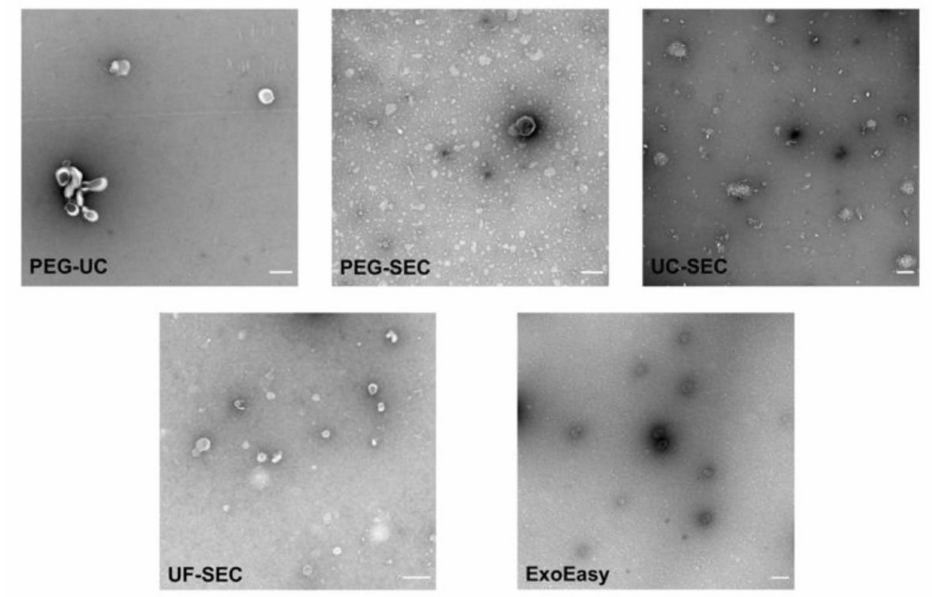
Figure 7. UF-SEC preparation allows the recovery of uEVs with cup-shaped appearance. Representative images of transmission electron microscopic analysis of uEV samples obtained with the different methods as indicated. Size analyses were performed using the ImageJ software. Mean diameters of the EV-like objects were calculated between 67.97 nm (UF-SEC) and 94.73 nm (PEG-UC). Scale bar: 0.2 µ